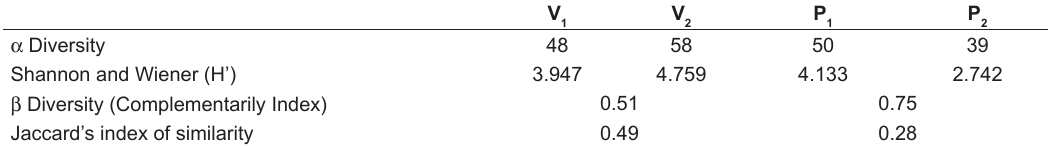
Table 3. Ecological attributes of algal and cyanobacterial communities calculated with average values obtained